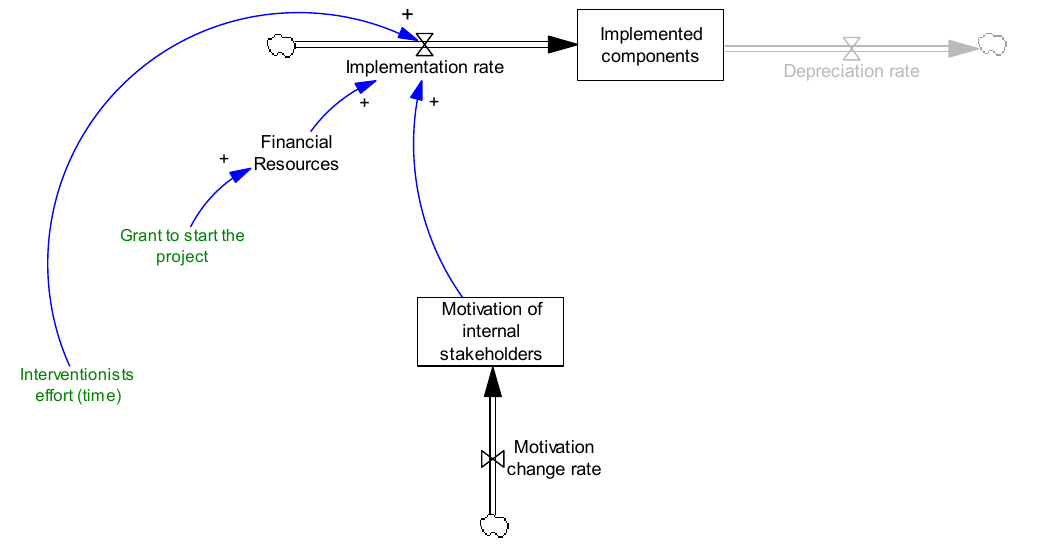
Figure 2. Effects of motivation and resources on implementation.